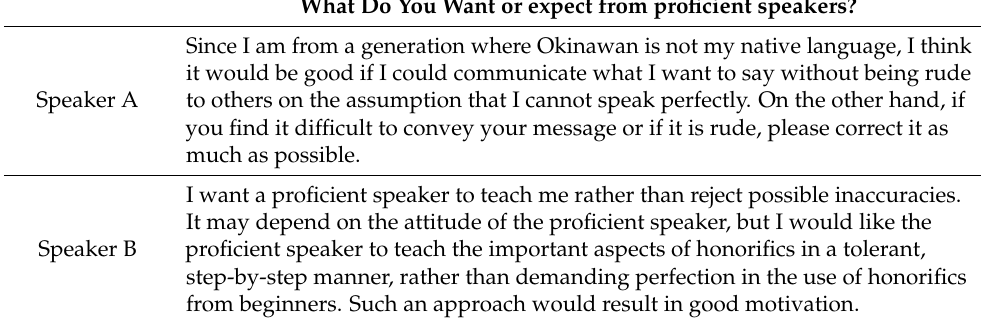
Table 7. What New Speakers Want from Proficient